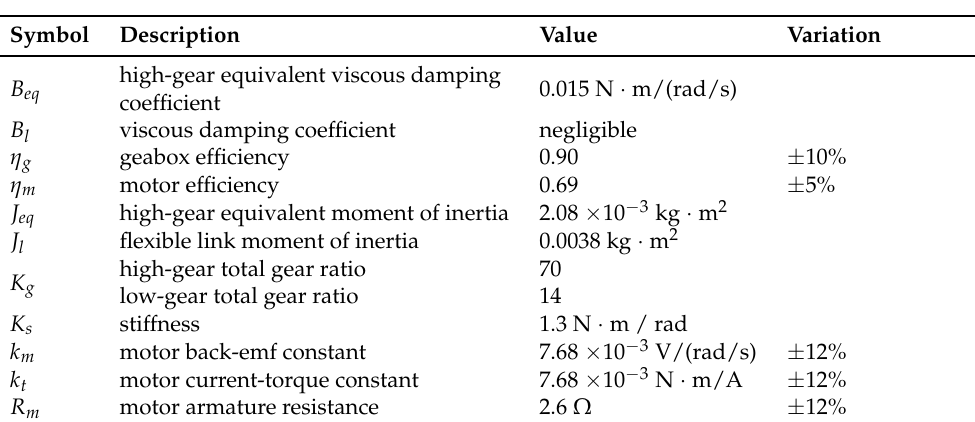
Table 1. Description of some model